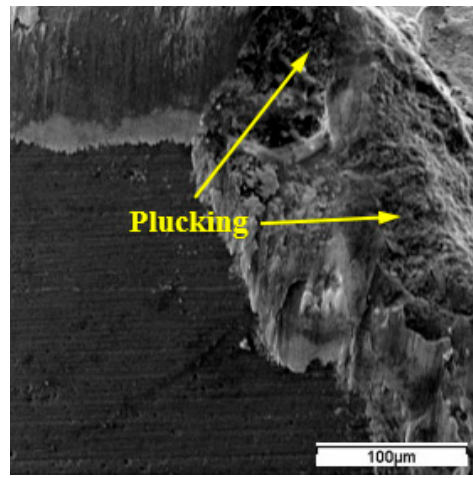
Figure 6. Plucking at the notching area of